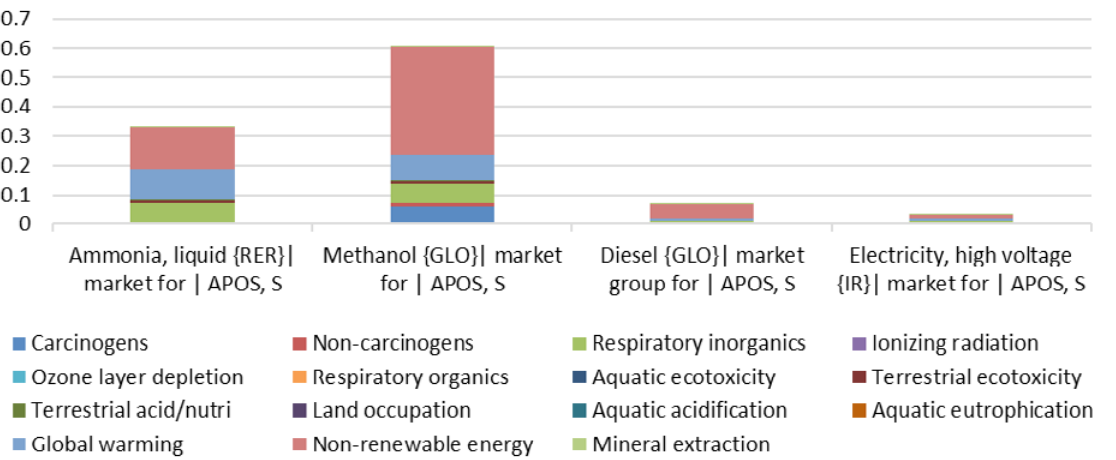
Taghizadeh Isini L, et al. Life Cycle Assessment of Formalin and Hexamine Production Units. J Adv Environ Health Res. 2022;